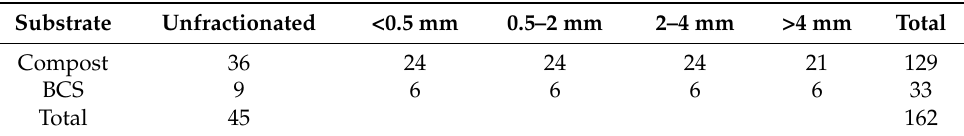
Table 2. Number of fractionated and unfractionated samples of compost and biochar compost substrates (BCS) materials.